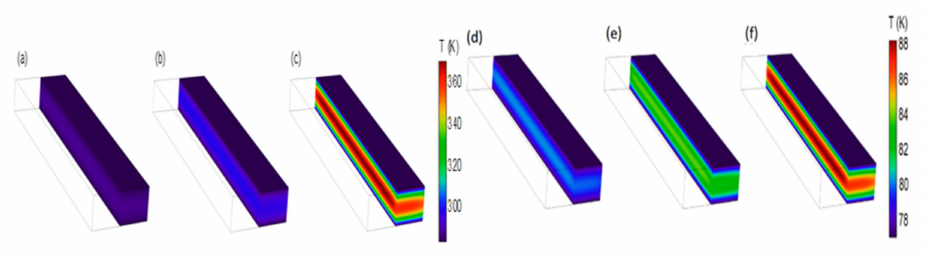
Figure 12. Temperature distribution of the top–bottom-pumped Ti:Sa slab for 300 W ( a ), 1 kW ( b ), and 5 kW ( c ) pump powers and 283 K cooling temperature, and for 10 kW ( d ), 20 kW ( e ), and 30 kW ( f ) powers and 77 K cooling temperature. For better visibility, only half of the slab is visualized. The pump wavelength was set to 532 nm, and crystal size of 30 × 10 × 3